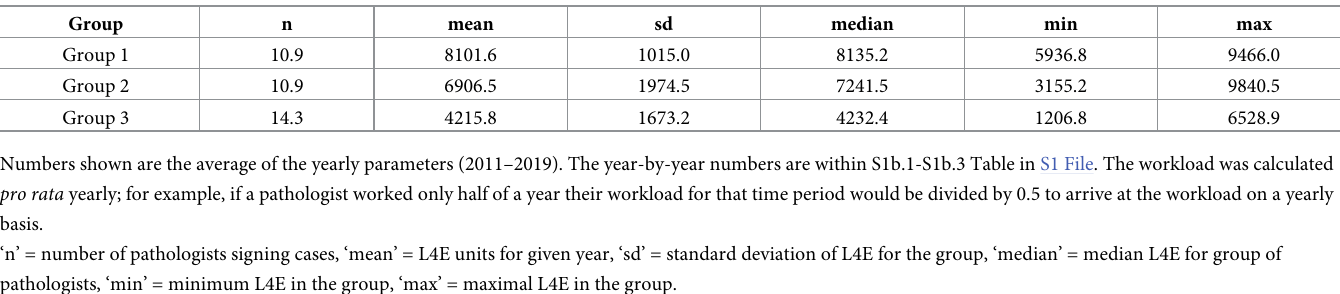
There were also significant differences between the pathologist groups. The least amount of work was in group 3 (3704.0 L4E workload units per FTE) and the greatest amount of work was in group 1 (9041.2 L4E workload units per FTE). The L4E/FTE difference was 4489.7/year or 100% higher in relation to group 3; the L4E/FTE was 8994.3/year for group 1 and 4504.6/ year for group 3 in 2019 –further details in the S1a Table in S1 File.